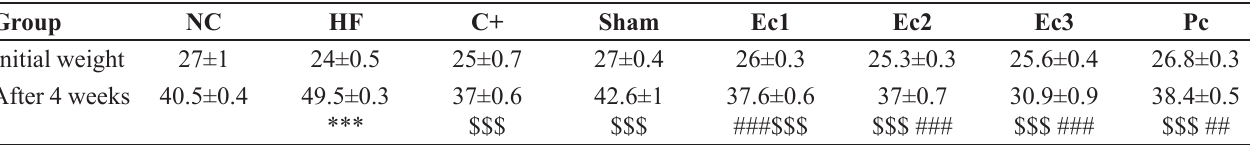
TABLE III - Comparison of body weights at the end of the experiment